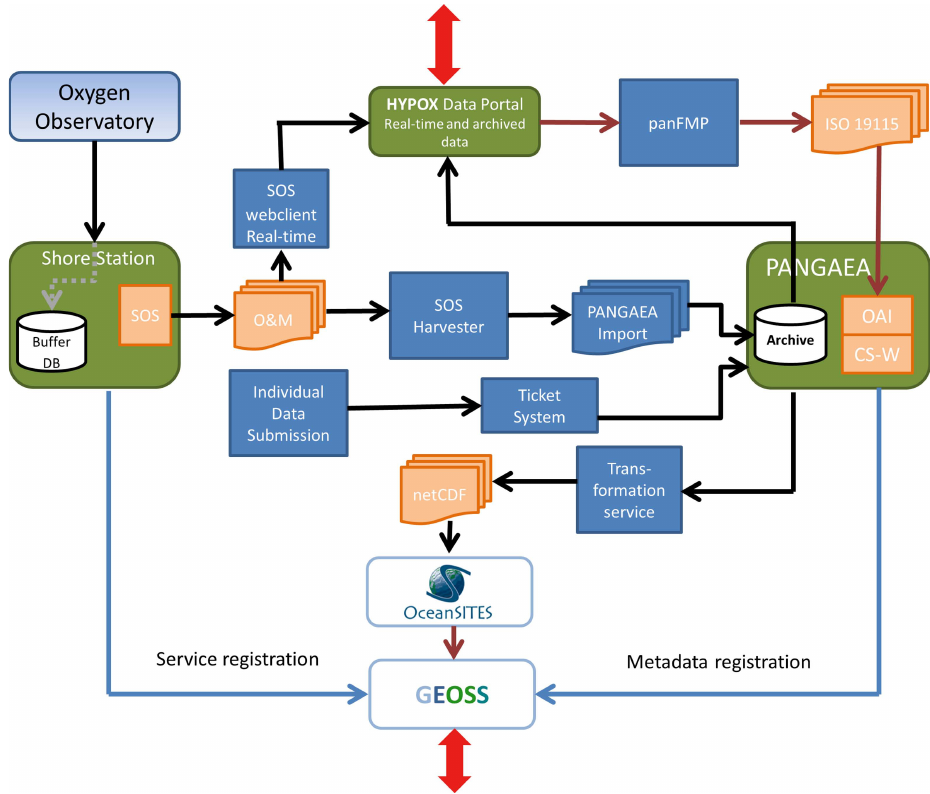
Fig. 28. Integration of the data flow from HYPOX sites to the central data archive Pangaea, and the link to other programs. The green boxes represent data buffers and permanent data archives, the blue boxes indicate processes involved in data flow and data transformation, and the reddish boxes represent the standards involved. Black arrows signify the flow of data and metadata from the cabled observatories in Koljoe Fjord and Loch Etive as well as from individual data sets submitted by HYPOX members. The HYPOX data portal is linked directly to the data archive and additionally receives data from the observatories in near real-time to allow immediate access to the most recent measurements. After transformation to netCDF format, the data are supplied via OceanSITES to GEOSS. The blue arrows represent additional services supplied to GEOSS by HYPOX, namely the provision of metadata and a georeferenced news feed, as well as the direct provision of data from cabled observatories. Interactive user access to data and metadata is possible via GEOSS and the HYPOX portal (red arrows), as well as through additional distributed web portals serving the specific needs of experts. See text for details and an explanation of the abbreviations